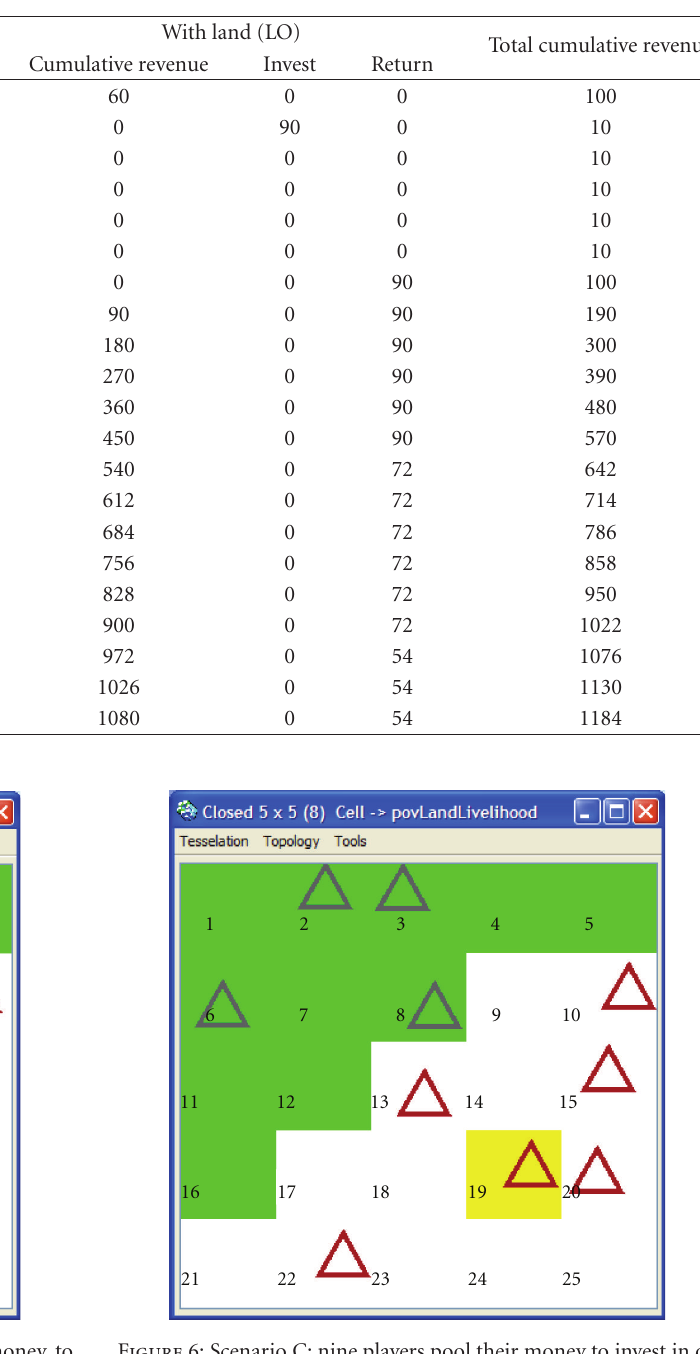
Figure 5: Scenario B: six players with land pool their money to invest in rubber plantations.